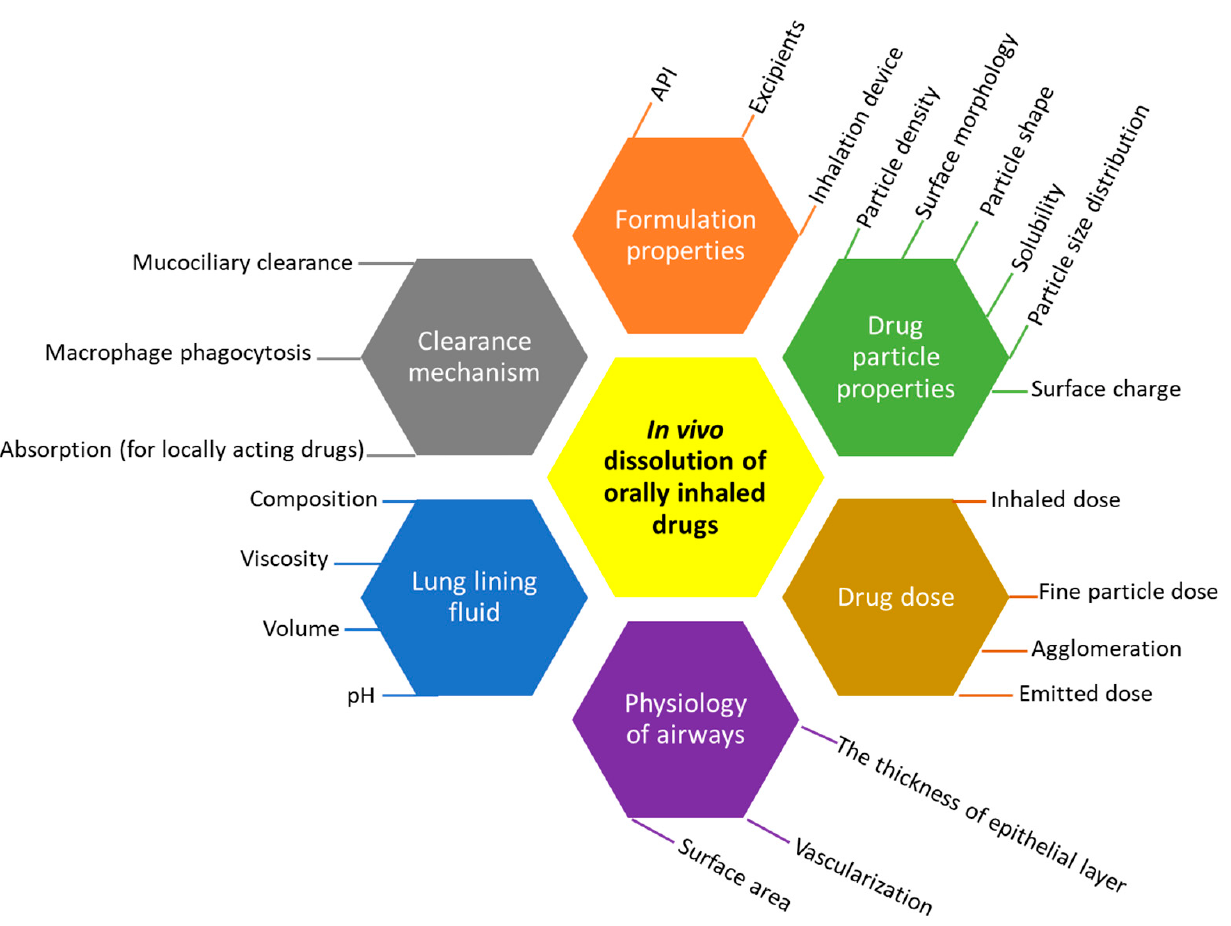
Figure 1. Parameters affecting the dissolution of inhaled API in the lung.